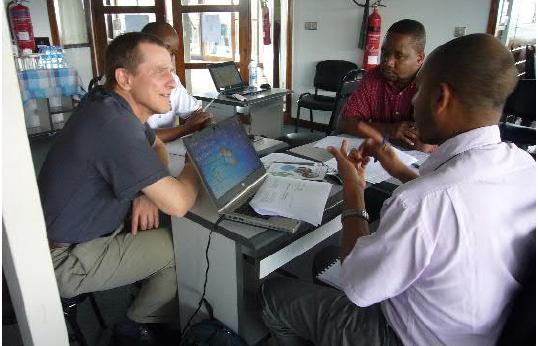
Figure 3. Planning competence development priorities for Sokoine University of Agriculture (SUA) in Dar es Salaam (May 2017).